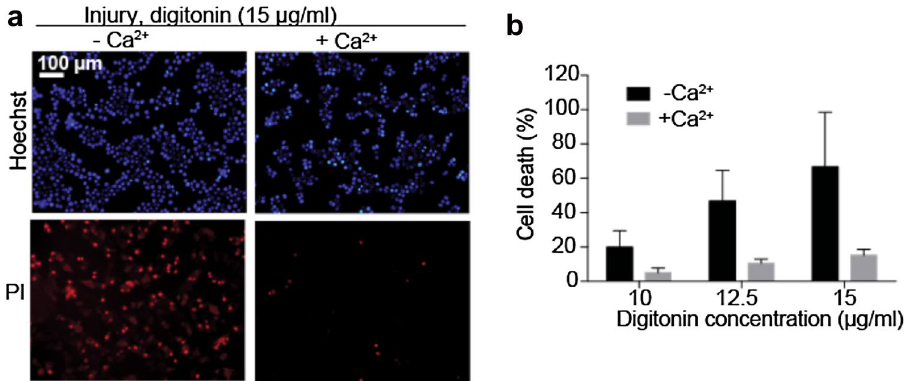
Figure 1. Cells repair from digitonin-induced PM injury in a Ca 2+ -dependent manner. ( a ) Representative images of MCF-7 cells injured by 10 min incubation in 15 µg/ml digitonin in the absence (left panel) or presence (right panel) of Ca 2+ and then assayed using impermeable PI staining and Hoechst 33,342 (permeable). ( b ) Percentages of PI-positive cells after injury with 10, 12.5 or 15 µg/ml digitonin. Mean and SD of biological